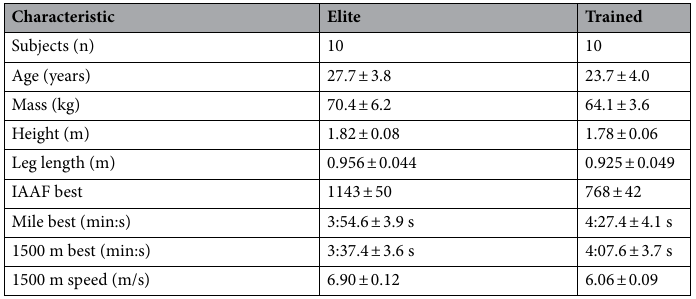
Table 1. Elite and trained cohort characteristics. Data are provided as mean ± standard deviation. IAAF Performance scores were calculated for the subject’s best 1500 m or mile performance, and the summary times or their event equivalent are provided for both the mile and 1500